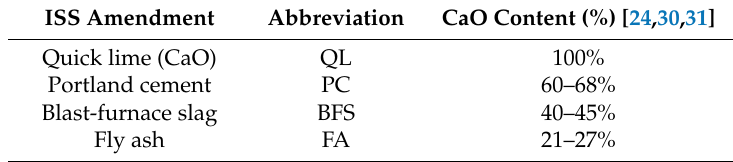
Table 1. The four in situ solidification/stabilization (ISS) amendments tested, their abbreviations, and the CaO contents. QL—quick lime; PC—Portland cement; BFS—blast-furnace slag; FA—fly